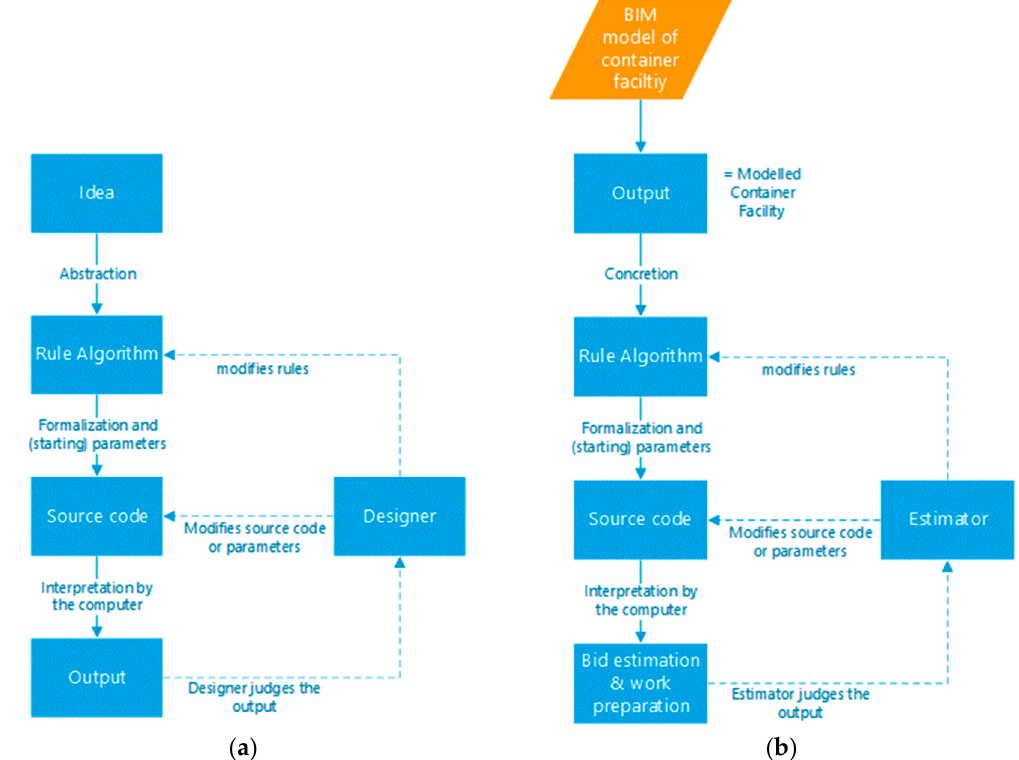
Figure 1. Computational design: ( a ) Conventional schema by Bohnacker et al. [15] vs. ( b ) Application in this study.